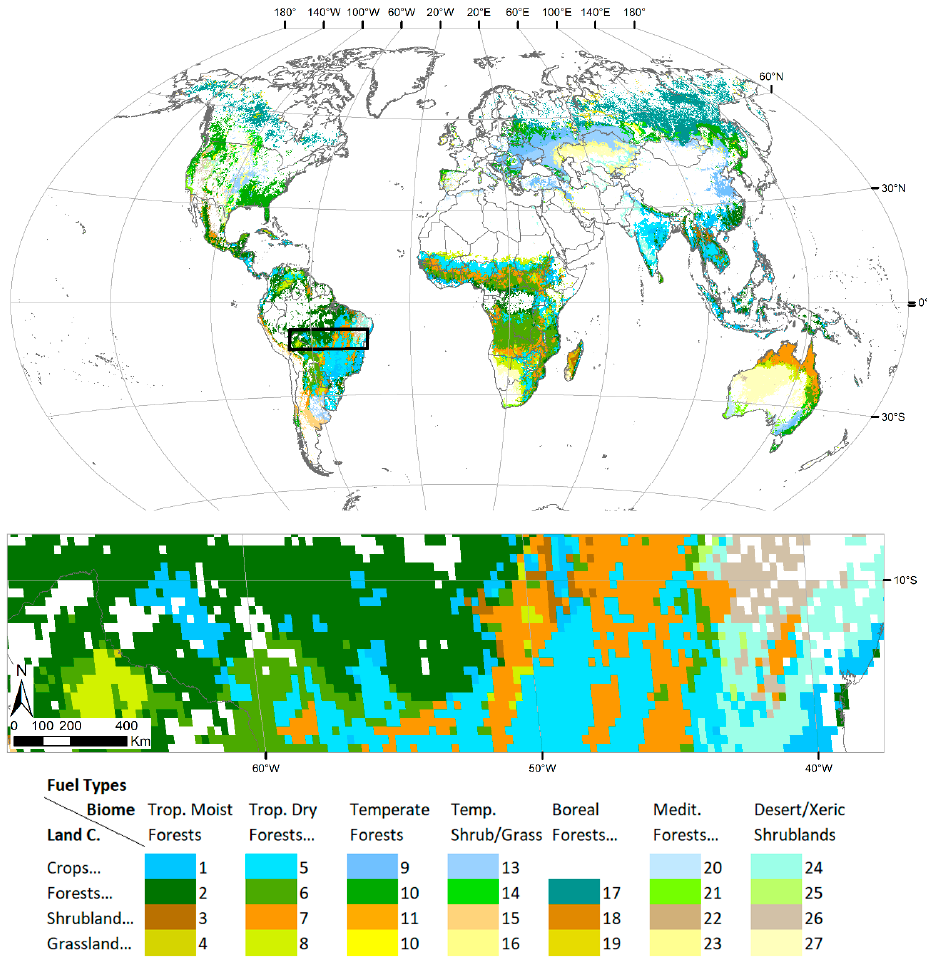
Figure A6. Spatial distribution of the fire types (FTs) (see main text and Table 1 for definition and further details). The bottom panel shows a zoomed region in central South America, as delineated in the global map.